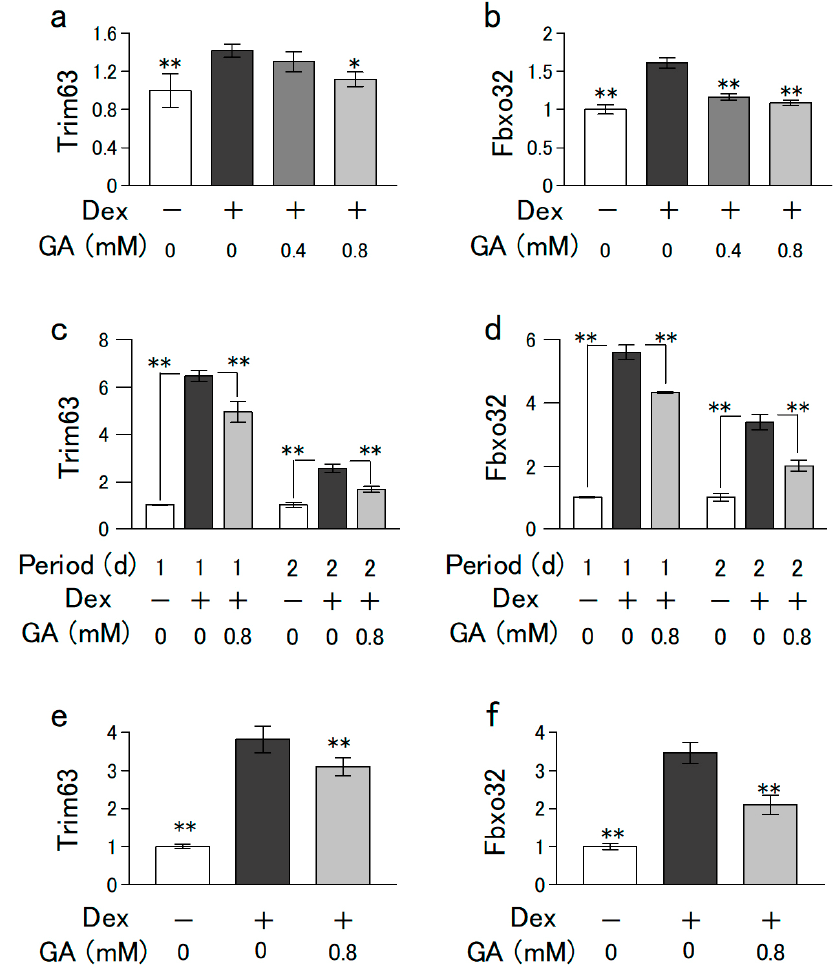
Figure 5. E ff ect of GA and Dex on the mRNA expression levels involved in muscle atrophy in C2C12 cells. ( a , b ) C2C12 cells grown to subcon fl uence in a growth medium (without GA) were further cultured in a di ff erentiation medium without GA for 6 d. The cells were further cultured for 1 d in a di ff erentiation medium with or without Dex (2.5 µM) and GA (0–0.8 mM). ( c , d ) C2C12 cells grown to subcon fl uence in a growth medium (without GA) were further cultured for the indicated days in a di ff erentiation medium with or without Dex (2.5 µM) and GA (0.8 mM). ( e , f ) L6 cells grown to subcon fl uence in a growth medium (without GA) were further cultured in a di ff erentiation medium without GA for 6 d. The cells were further cultured for 1 d in a di ff erentiation medium with or without Dex (2.5 µM) and GA (0.8 mM). mRNA levels of ubiquitin ligases (Trim63 and Fbxo32), markers of muscle atrophy, were measured using qPCR. Values are presented as mean ± SD of three independent experiments. ( a , b , e , f ) Data were analyzed using a one-way ANOVA followed by Dun- ne tt ’s post hoc comparison test. Mean value was signi fi cantly di ff erent from that of Dex: ( c , d ) Data were analyzed using a one-way ANOVA followed by Tukey post hoc comparison test. ** p < 0.01, * p < 0.05.